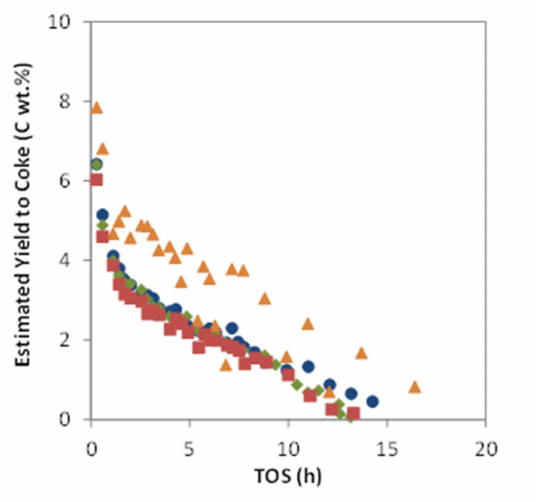
Figure 5. Estimated yield to coke versus TOS for catalysts MoZ5-SSR-SC ( ), MoZ5-SSR-DC ( ), MoZ5-IW-SC (Definitions/applsci-1225460-i006.pdf), and MoZ5-IW-DC ( ), at 973K, atmospheric pressure and w/F = 16 g ·